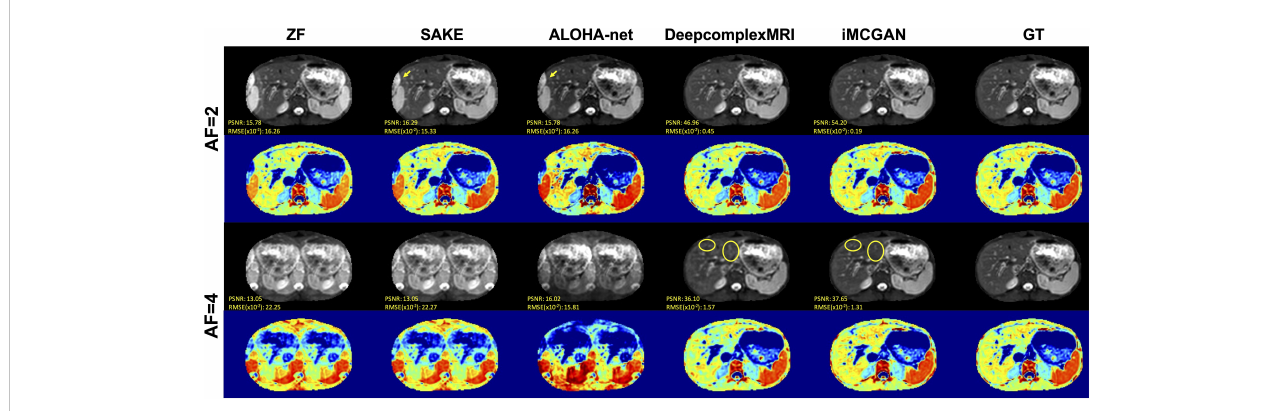
FIGURE 7 The visual comparison between several advanced DWI (b = 800 s/mm 2 ) reconstruction methods under different AFs. The fi rst and third row shows the reconstructed DWI with corresponding PSNR and SSIM values, and the second and fourth row shows the corresponding ADC